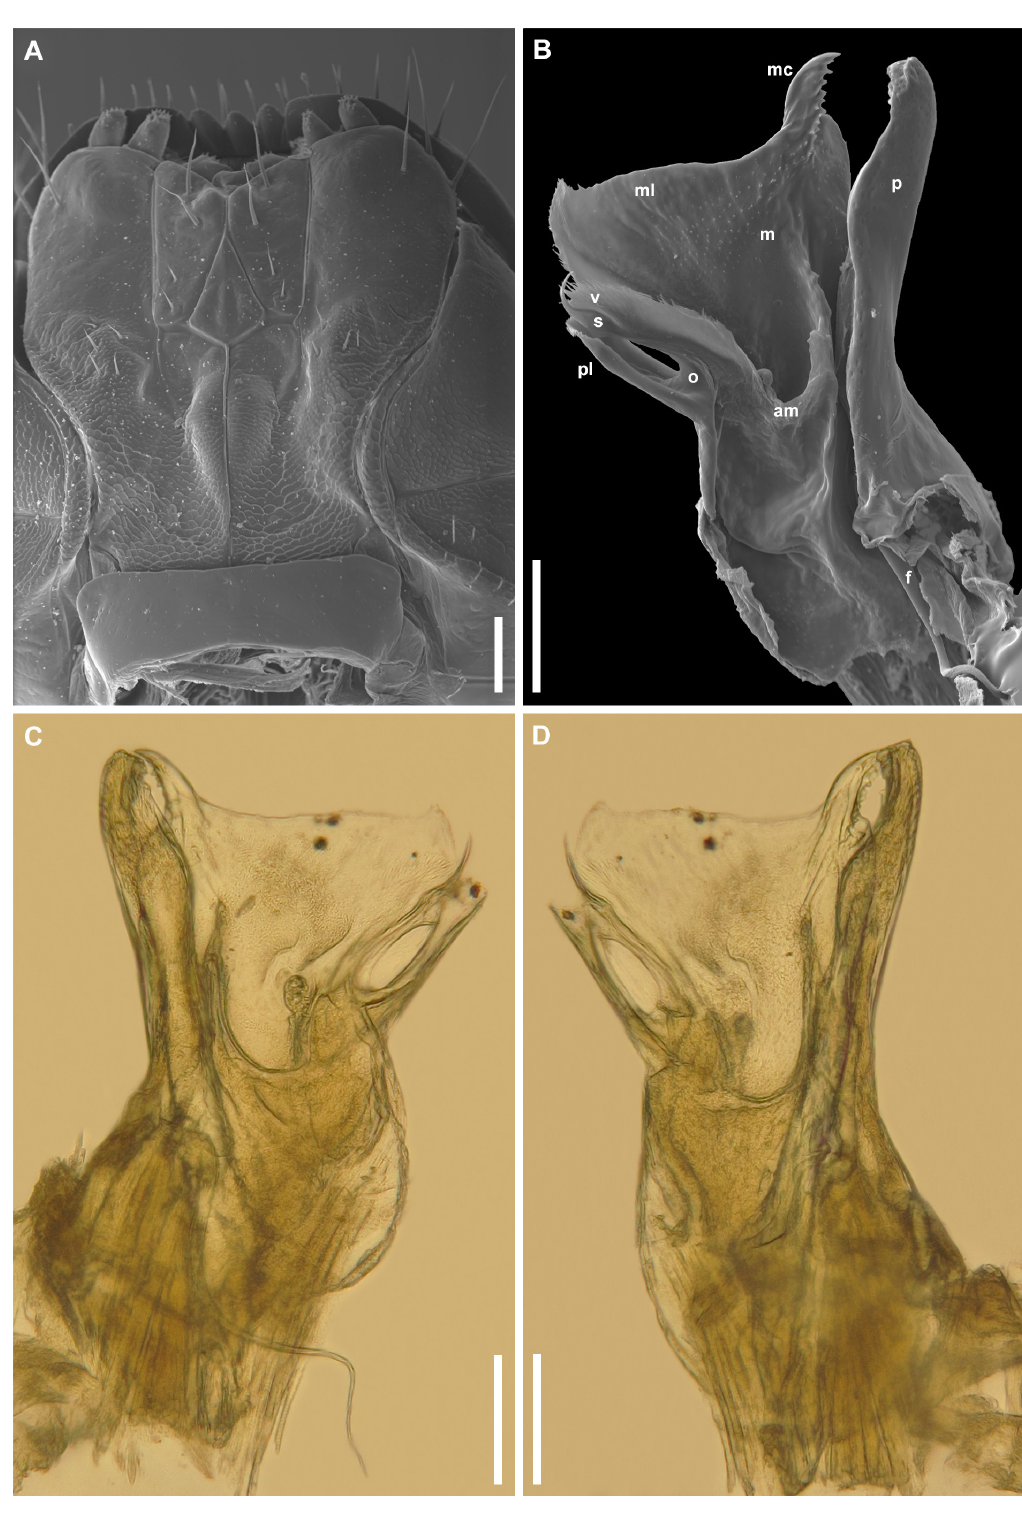
Fig. 15. Leucogeorgia satunini (Lohmander, 1936) comb. nov., ♂ from Kelasurskaya Cave (ZMUM). A . Head, ventral view. B . Right gonopods, mesal view. C . Left gonopods, mesal view. D . Left gonopods, lateral view. Abbreviations: am = accessory membrane; f = flagellum; m = mesomere; mc = mesomeral claw; ml = mesomeral lamella; o = opisthomere; p = promere; pl = protective lamella; s = solenomere; v = velum. Scale bars: 0.1